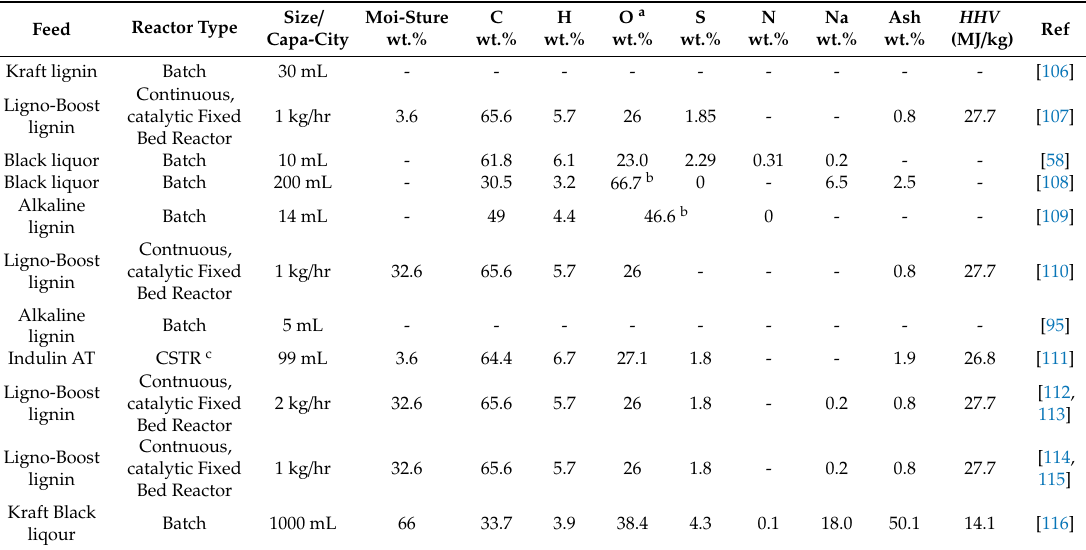
Table 5. Feedstocks and process types used in the studies reported in this review. Both elemental composition and the HHV of the feedstocks are given on a dry matter